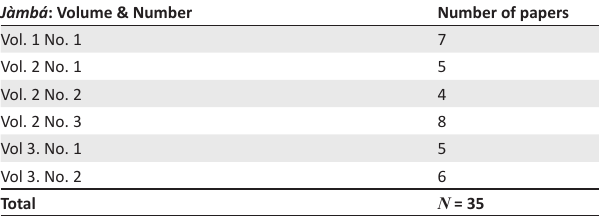
TABLE 3: Jàmbá editions and number of